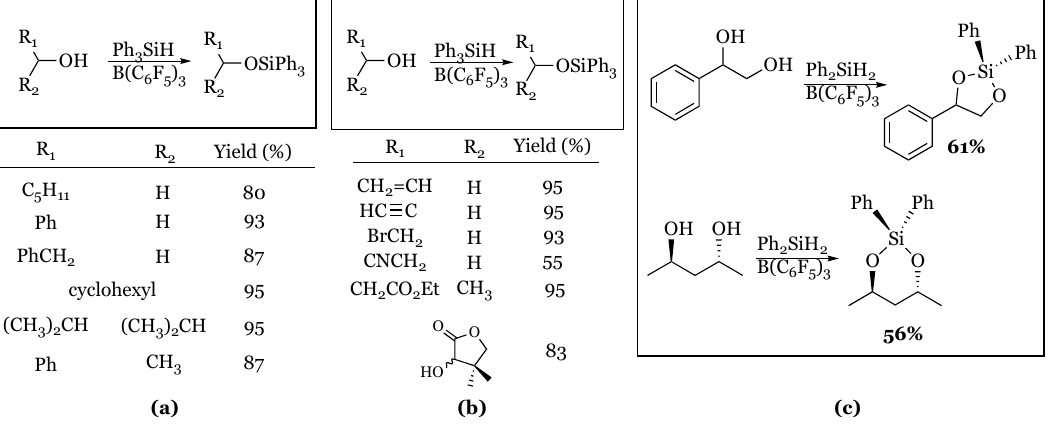
Figure 11. Alcohol and diol reactivity: ( a ) Silylation of primary and secondary alcohols; ( b ) silylation of alcohols in the presence of reactive functional groups; ( c ) silylation of 1,2-, and 1,3-diols with diphenyl silane.